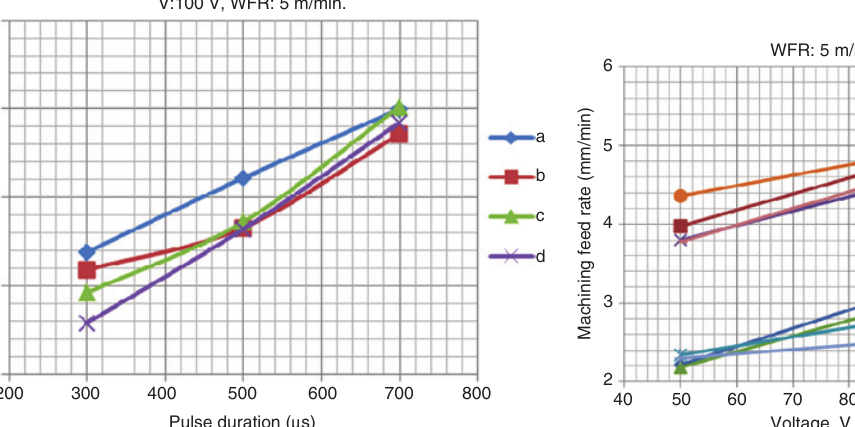
Figure 8 Machine feed rate: pulse duration.